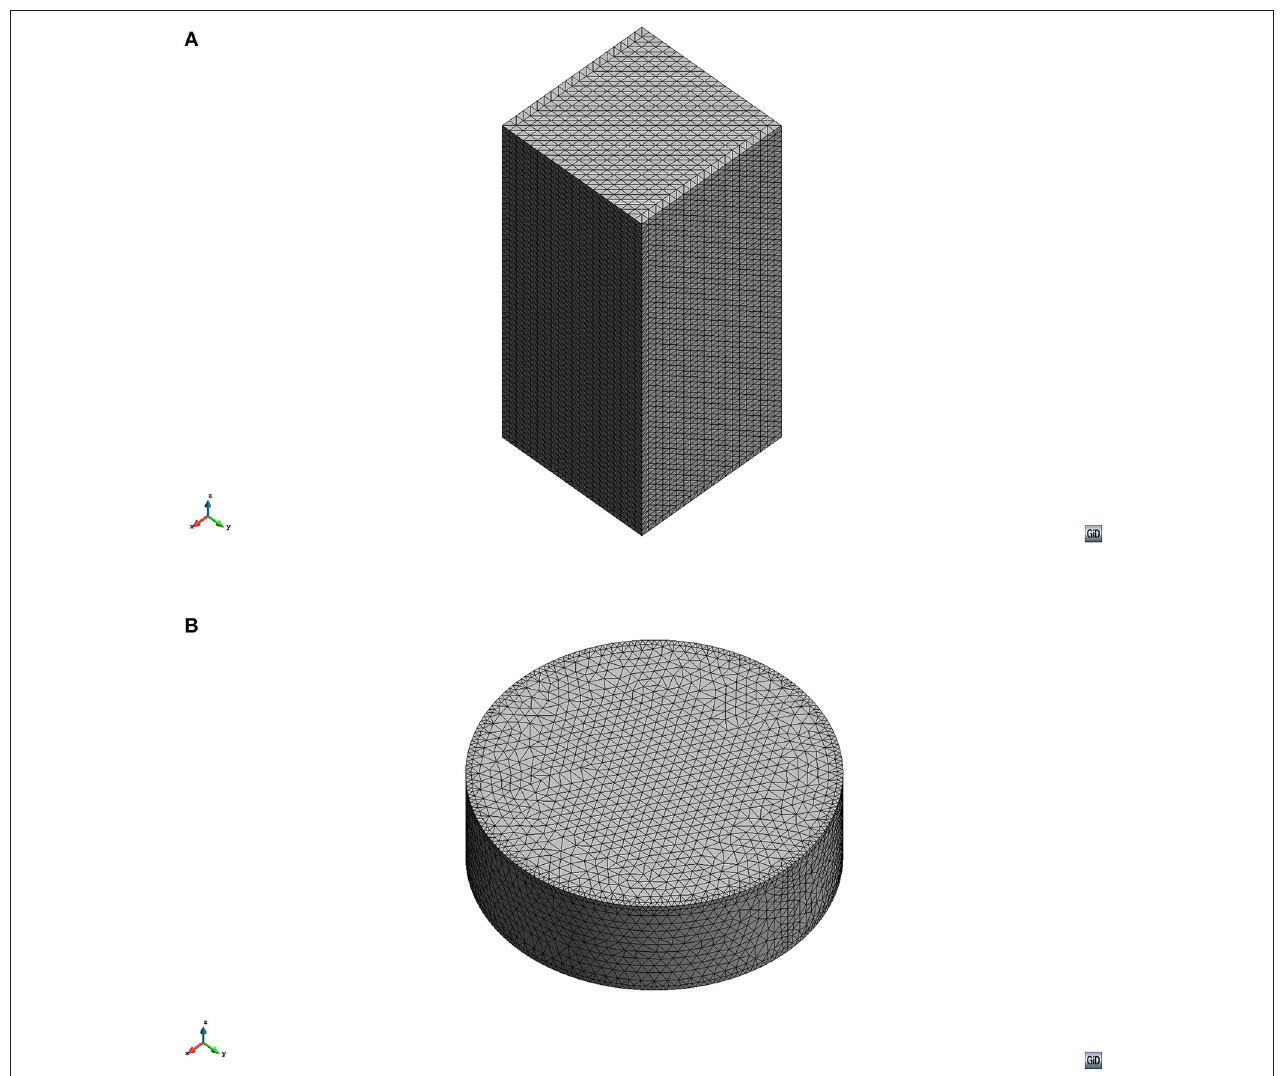
FIGURE 1 | FE models used in this study: (A) Cuboidal model to mimic Chandran and Barocas (2004) samples; (B) Cylindrical model to mimic Busby et al. (2013) samples.